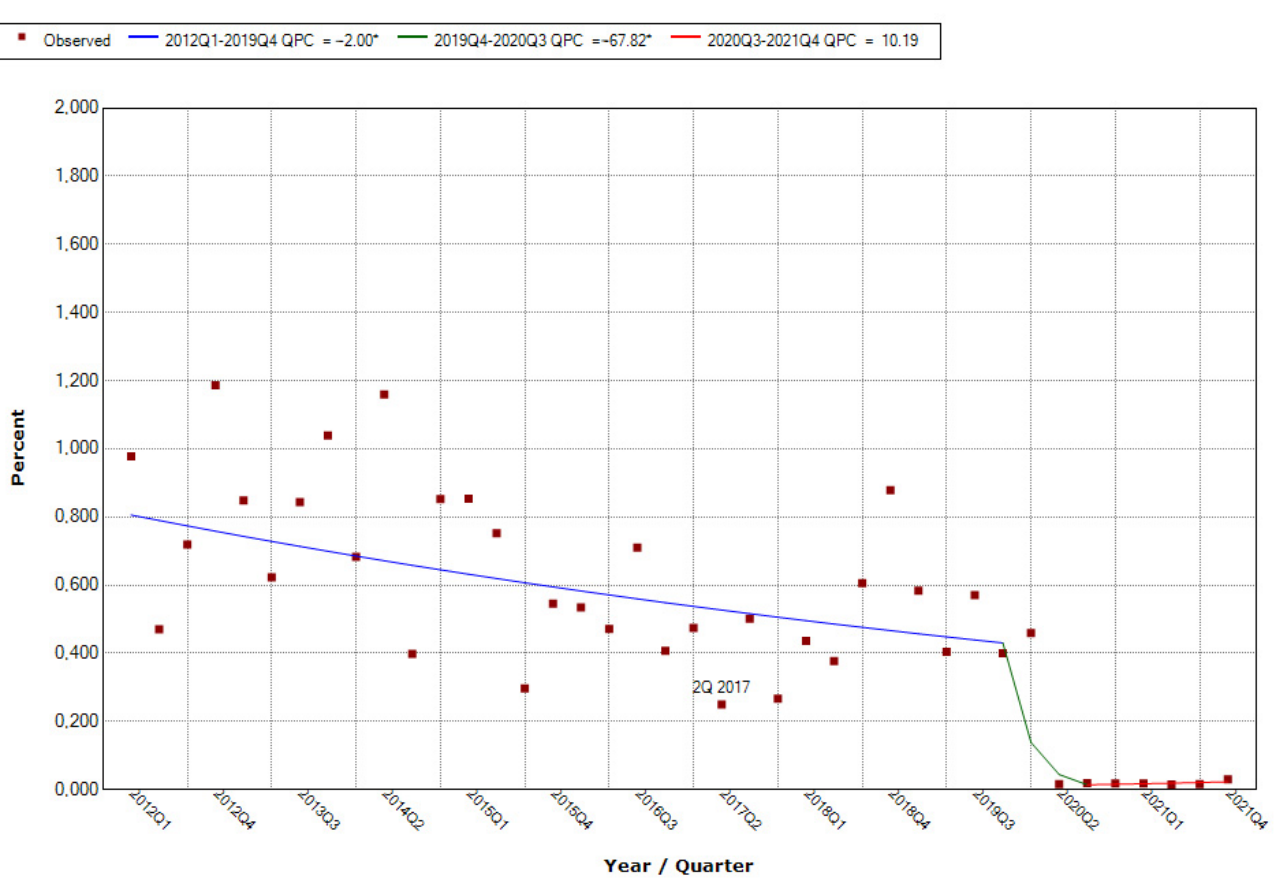
Figure A33. Percentage of products containing cranberry derivatives in individual quarters in the period from 2012 to 28 November 2021. Joinpoints mark trend turning points. The date above the observation indicates the moment of publication of the scientific opinion/resolution.